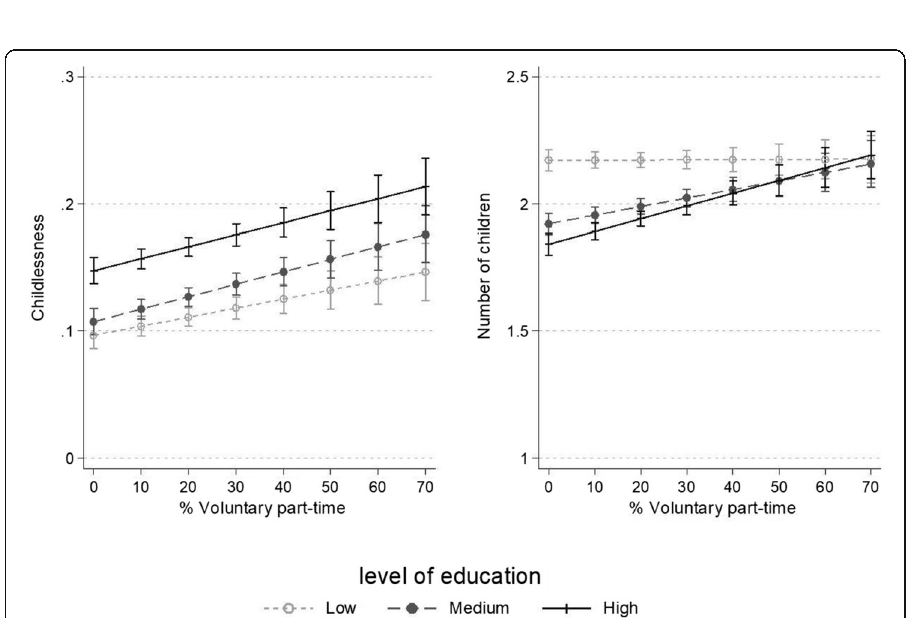
Fig. 2 Predicted probabilities of being without children (left) and predicted number of children (right) by share of female part-time work and female level of education. Source : EU-LFS 2005-2010, author ’ s elaboration. Note : Predictions refer to Tables 10 and 11 in the Appendix, models C3b and N3b. 90% confidence intervals